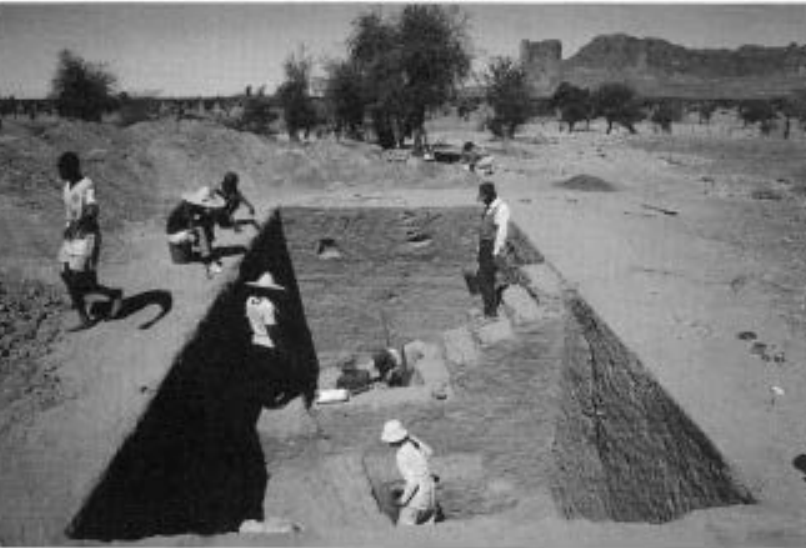
Figure 3 The main exposure at Tango M a are Diabal mid-way through the 1995 season.